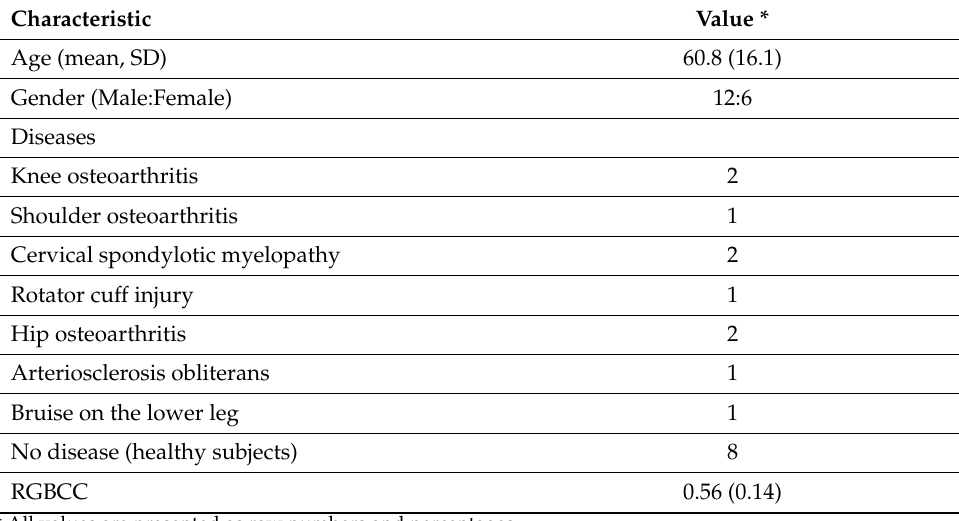
Table 3. Demographics and clinical characteristics of control subjects.